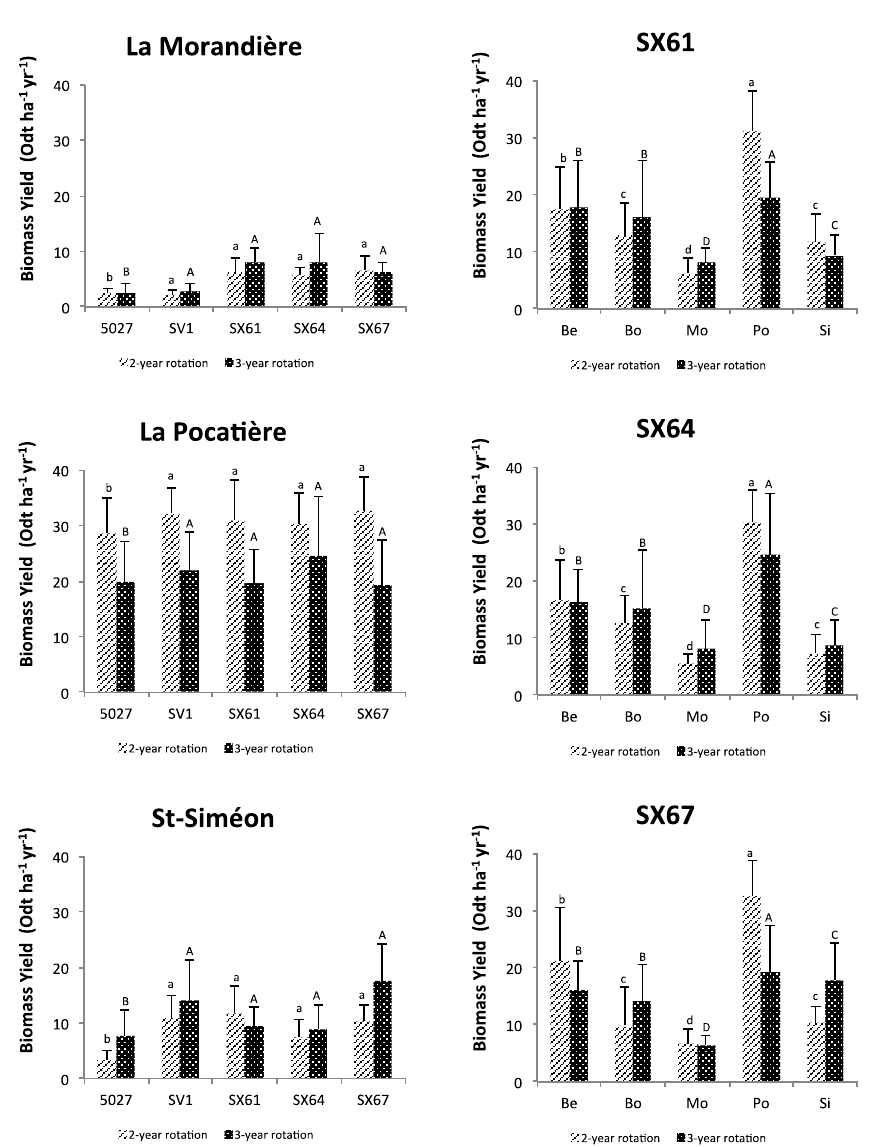
Figure 4. Annual biomass yield of willow plants under different rotation cycles. Values are means ( n = 9; SD on the top of each bar) for each site (Be = Beloeil; Bo = Boisbriand; Mo = La Morandière; Po = La Pocatière, Si = St-Siméon) and cultivar. A 5% significance level was adopted for identifying significant treatment effects according to Tukey’s HDS test. Lowercase letters were used to highlight significant difference in two-year rotation. Capital letters identify significant differences in the three-year rotation.